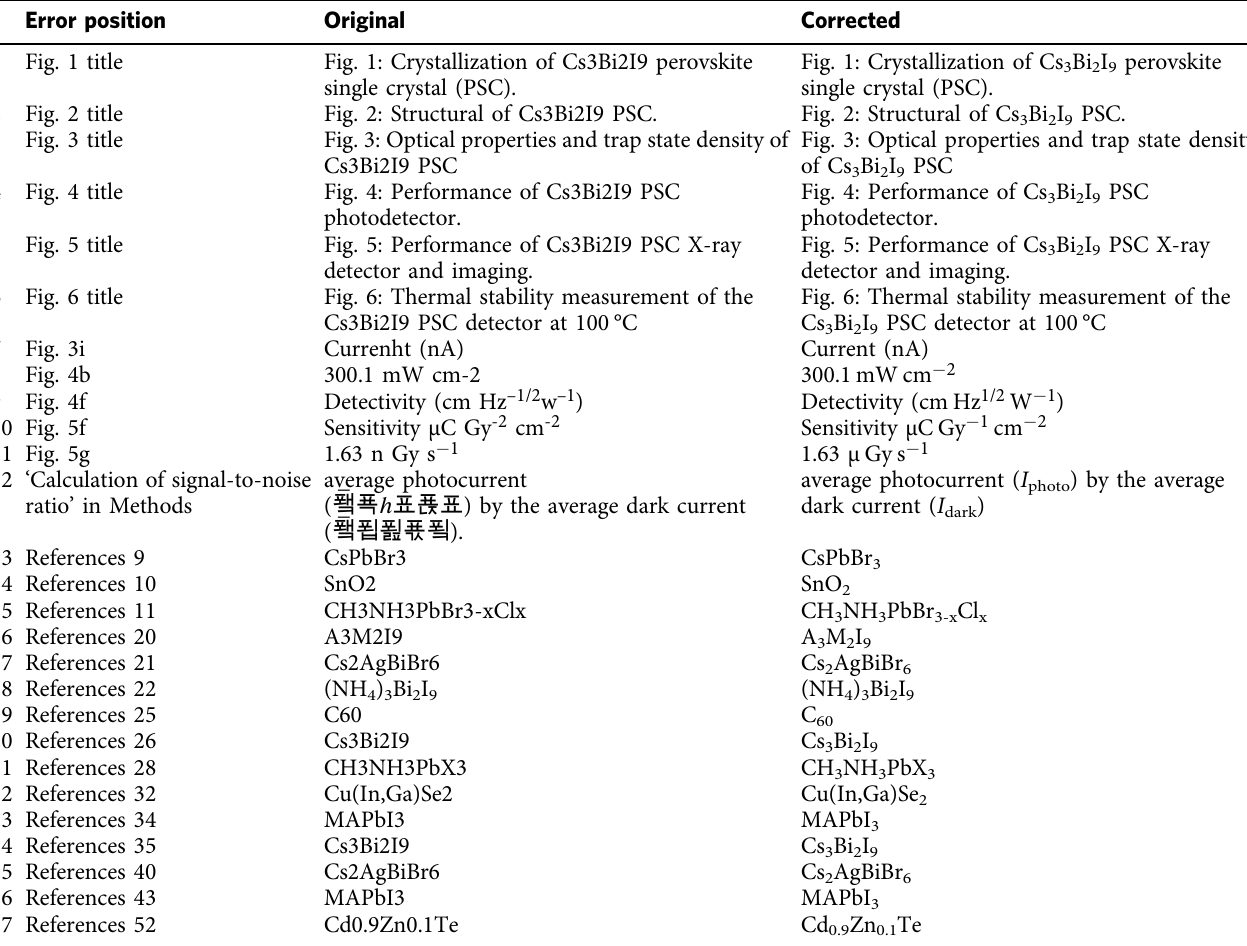
Fig. 1: Crystallization of Cs 3 Bi 2 I 9 perovskite single crystal (PSC). Fig. 3: Optical properties and trap state density of Cs 3 Bi 2 I 9 PSC Fig. 4: Performance of Cs 3 Bi 2 I 9 PSC photodetector. Fig. 5: Performance of Cs 3 Bi 2 I 9 PSC X-ray detector and imaging. Fig. 6: Thermal stability measurement of